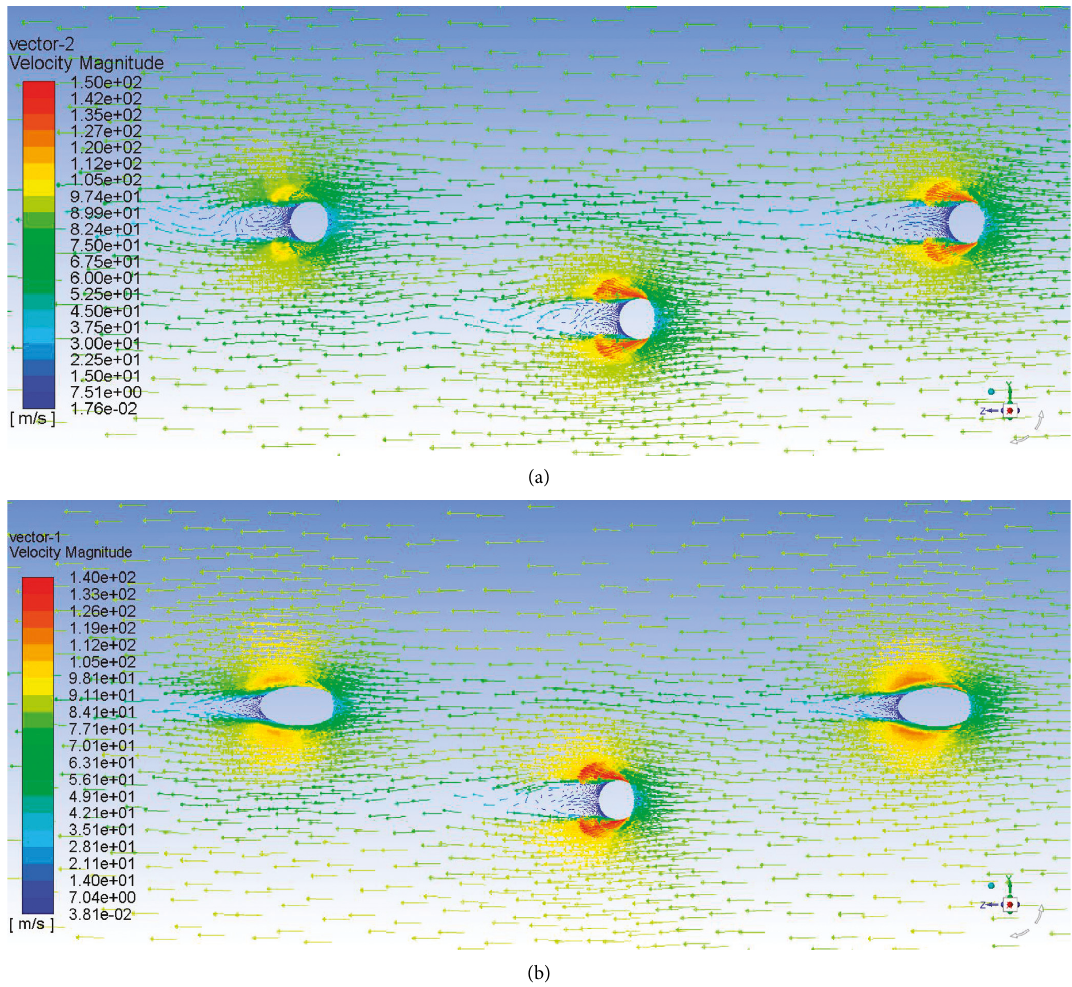
Figure 21: Velocity vectors for SSS87 pantograph panhead bars at a speed of 300km/h: (a) Rounded edge cross-section; (b) elliptic edge